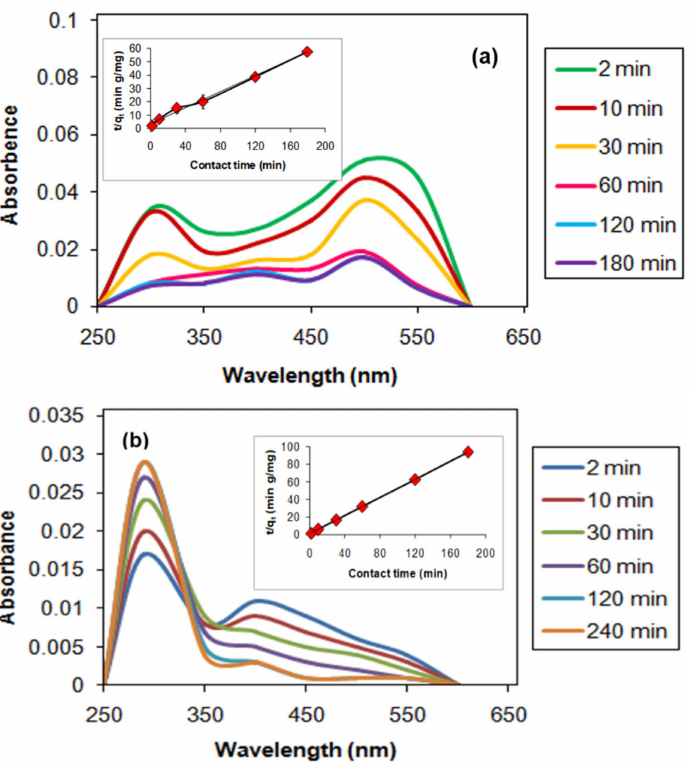
Figure 11. ( a ) Photocatalytic degradation of CR (inset-pseudo second order kinetic model). (Experi- mental conditions: pH, 3.0; adsorbent dose, 0.1 g and CR concentration, 2.0 mg/L). ( b ) photocatalytic degradation of PNP (inset-pseudo second order kinetic model). (Experimental conditions: pH, 3.0; adsorbent dose, 0.01 g and PNP concentration, 2.0